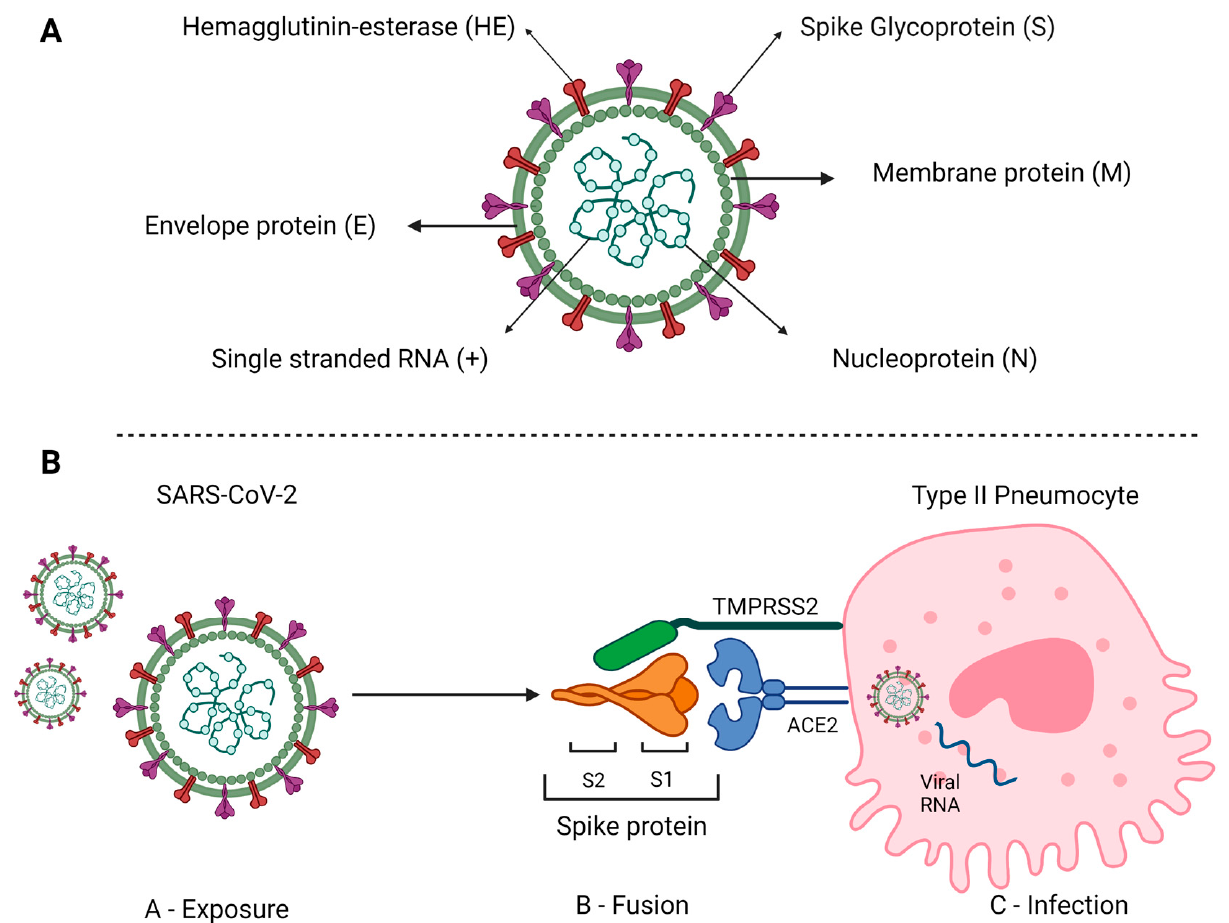
Figure 1. Schematic representation of SARS-CoV-2 structure and host cell invasion. ( A ) This is an enveloped, positive-sense RNA virus containing the following main structural proteins: spike (S) and membrane (M) glycoproteins, and envelope (E) and nucleocapsid (N) proteins. ( B ) Virus exposition occurs primarily through the upper airways, with tracheal and lung cells being the primary targets of infection. The interaction with these cells involves the spike protein expressed on the surface of the viral particle and comprising the S1 and S2 domains which interact with the host membrane proteins ACE2 and TRPMSS2, respectively, resulting the virus/cell fusion. Once the processes of fusion and the passage of the virus’s genetic material into the cell are completed, replication starts. Source: Created with Biorender.com.